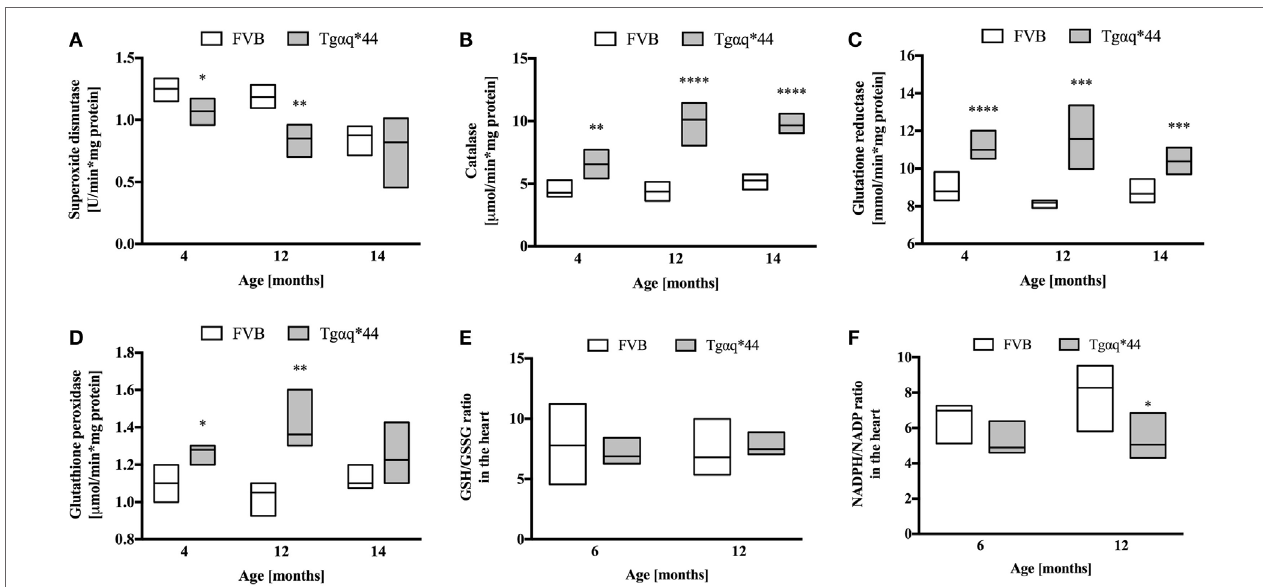
FigUre 8 | Levels of endogenous antioxidant enzymes activity and redox state in the hearts of Tg α q*44 vs FVB mice. (a) Superoxide dismutase, (B) catalase, (c) glutathione reductase, (D) glutathione peroxidase (GPx), (e) GSH/GSSG ratio, and (F) NADPH/NADP ratio. Data represent median ± IQR, N = 4–8 mice/group. Statistical significance between aged-matched groups was assessed using an unpaired two-tailed t -test, except data for GPx and 4-month data for catalase, where the non-parametric Mann–Whitney U test was used; * P < 0.05, ** P < 0.01, *** P < 0.005, and **** P < 0.001.